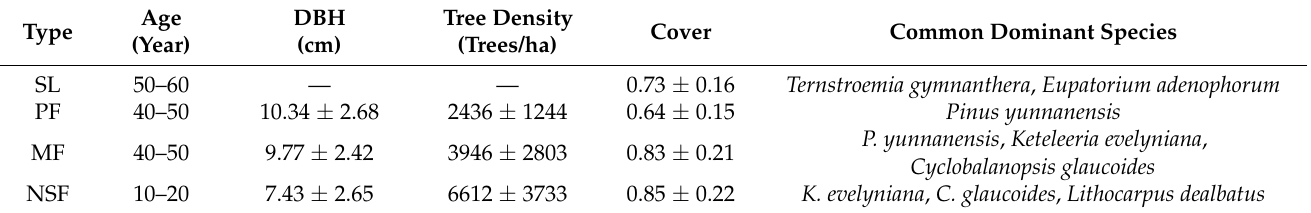
Table 1. Species composition and structural attributes for four vegetation restoration types.